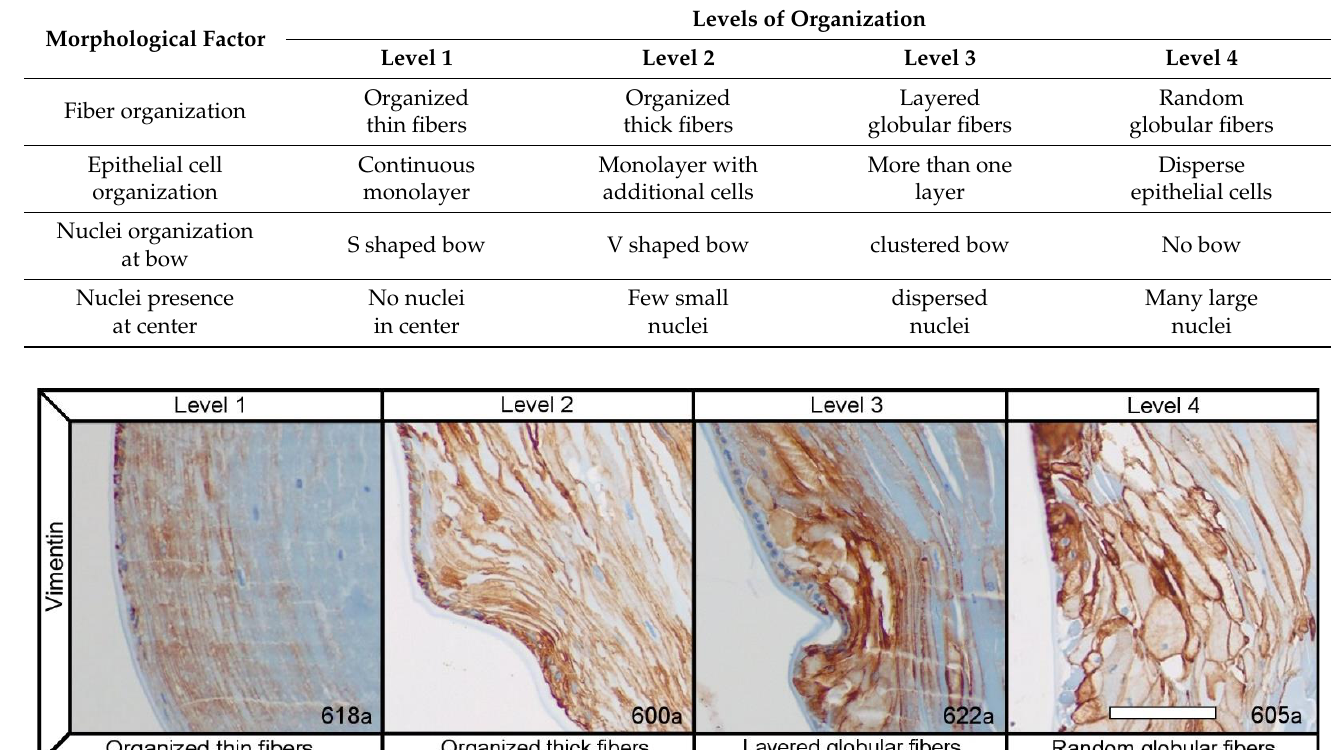
Table 2. Explanation of the levels of organization, of different morphological factors, that we used to categorize and evaluate our samples. Level 1 represents the ideal organization of cells in a normal human lens. Level 4 represents a completely unorganized cell mass. Fiber organization is illustrated in Figure 2 and nuclei organization at bow illustrated in Figure 3.